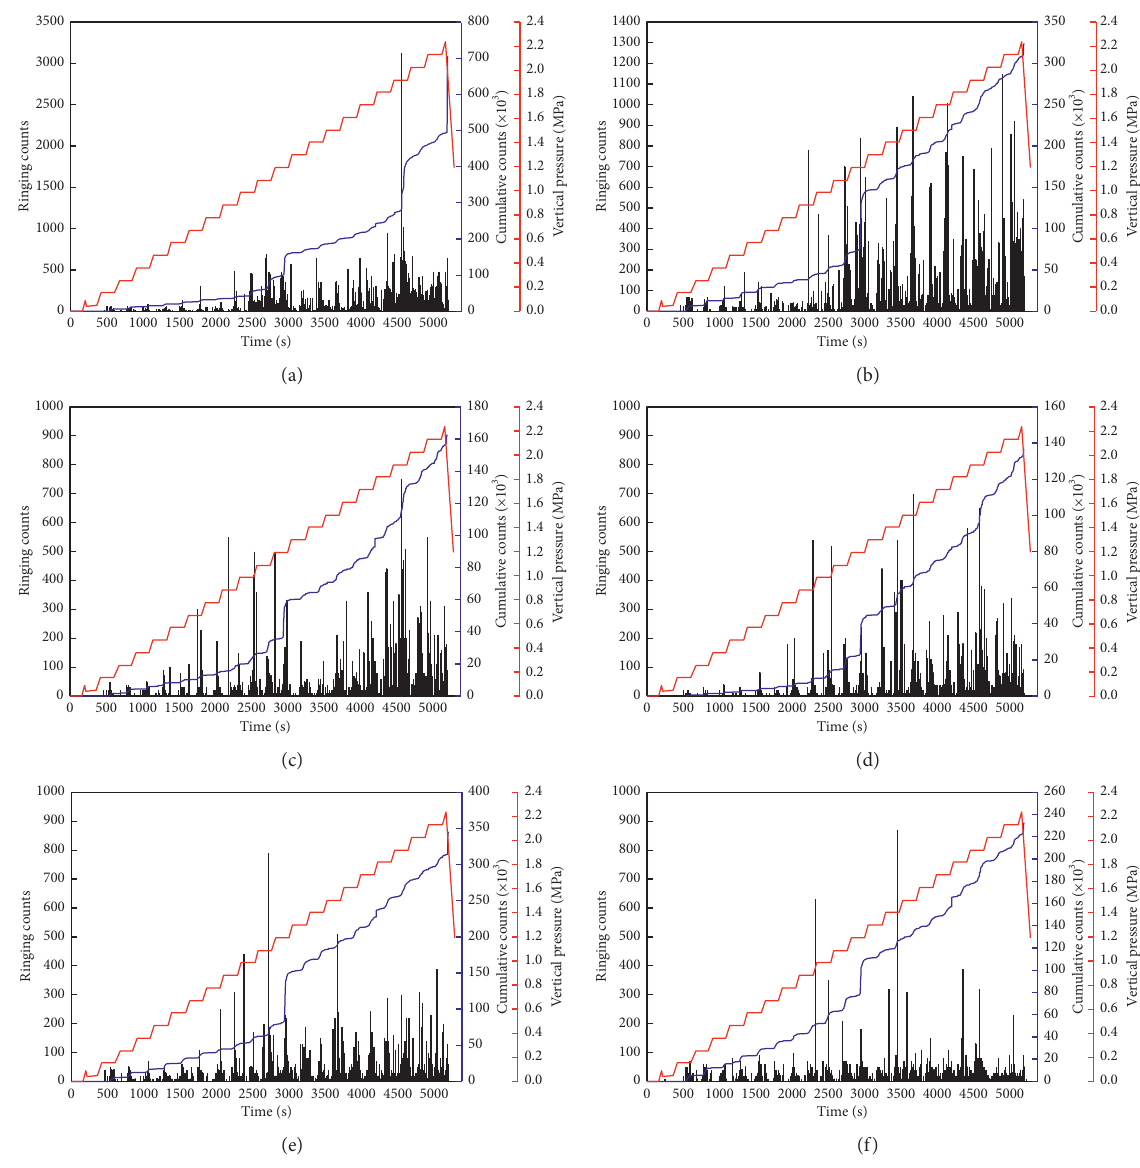
Figure 8: Variation of AE ringing counts and load with time for AE sensors. (a) AE sensor 5. (b) AE sensor 6. (c) AE sensor 1. (d) AE sensor 2. (e) AE sensor 8. (f) AE sensor